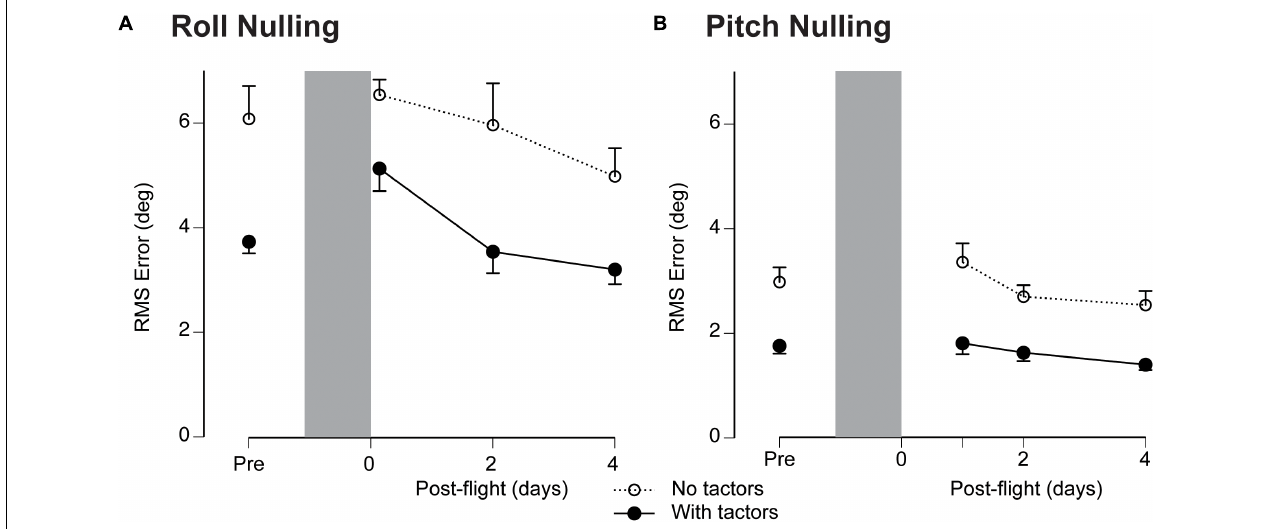
FIGURE 3 | RMS error values averaged for all subjects ( ± SE) for the nulling tasks during roll tilt (A) and pitch tilt (B) before (Pre) and after spaceflight without (open symbols) and with (filled symbols) the tactors. Shaded areas represent the flight (not at scale).